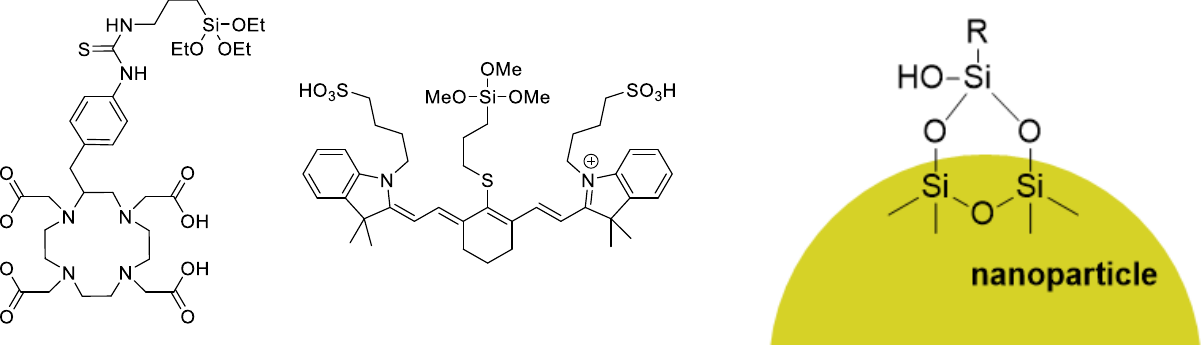
Figure 17. Structures of the silylated DOTA and cyanine derivatives used to functionalize the silica nanoparticles ( left ). Example of how the silyl groups interact with the silica nanoparticle surface ( right ).